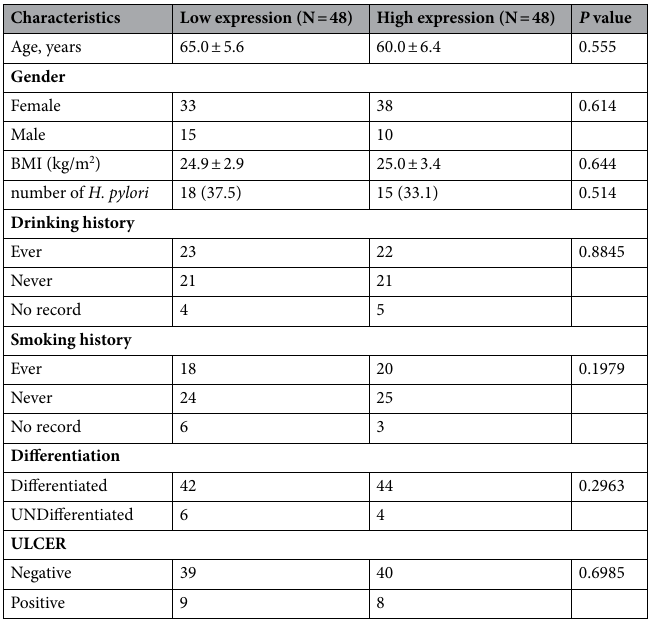
Table 1. Demographic and clinical parameters of EGC patients subjected to ESD